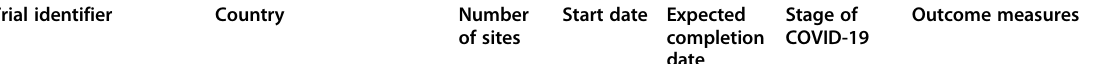
Table 1 General characteristics of the included trials